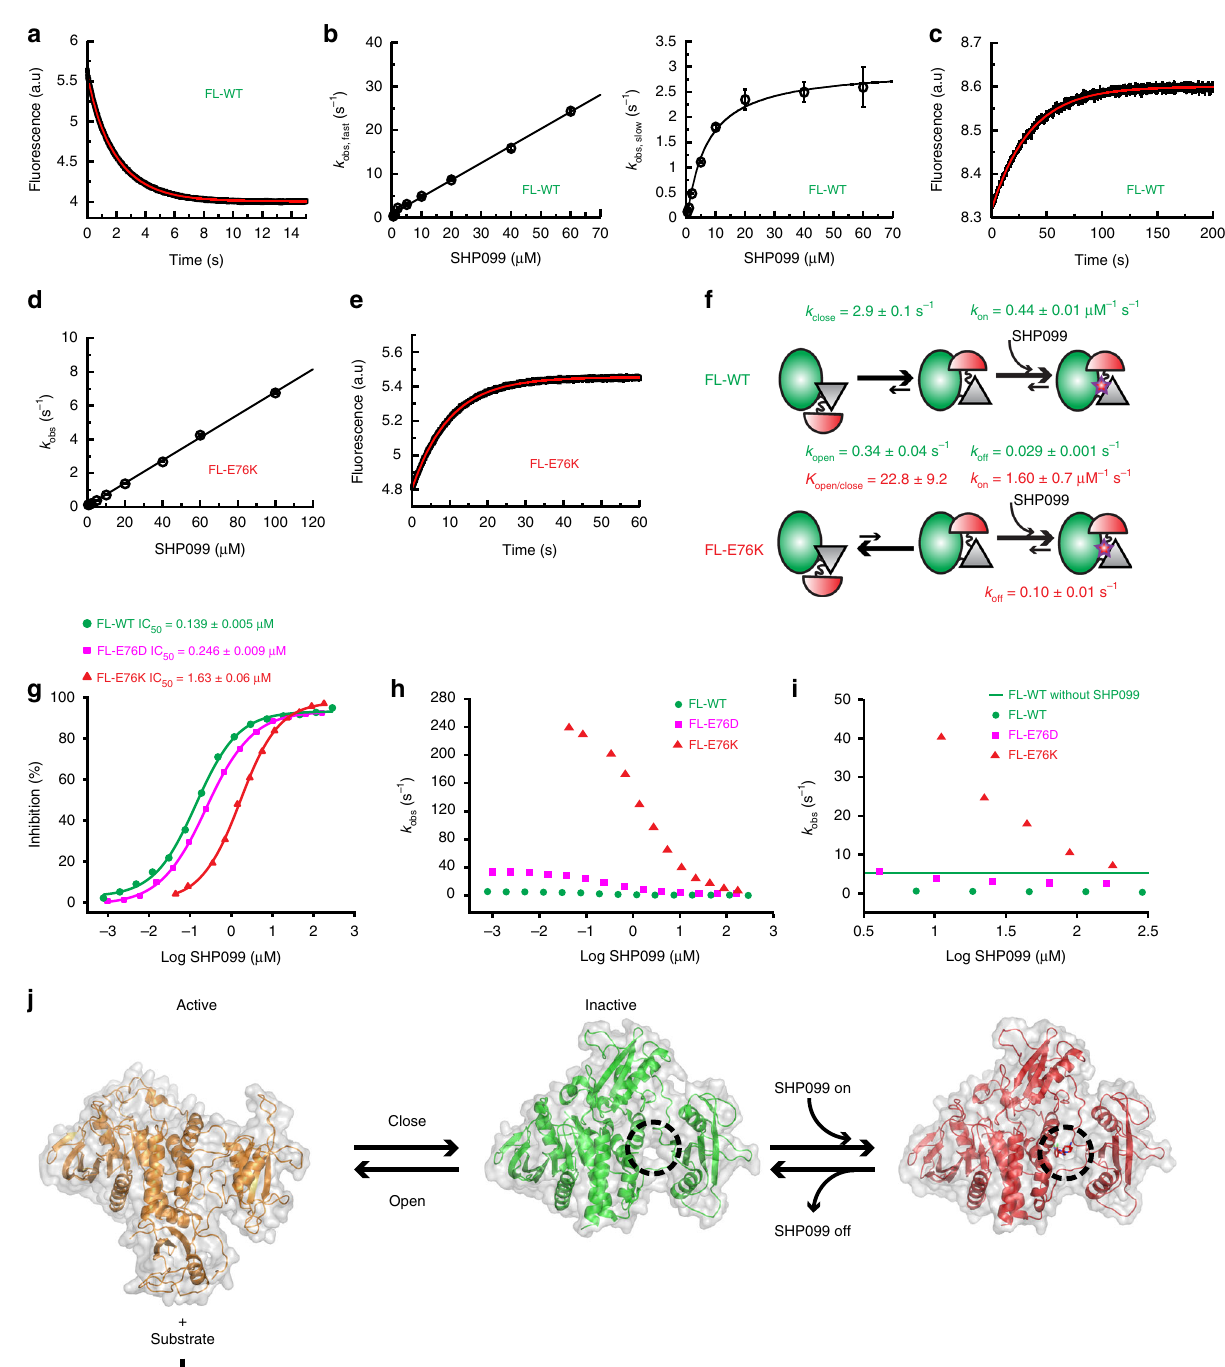
results beg the question: What are the implications of these kinetic differences for drug development? Although SHP099 has been shown to possess excellent potency against FL-WT 1 , it should have a much weaker IC 50 for the oncogenic mutants based on our binding kinetics. Indeed, the FL-E76K mutant experiences a signi fi cantly weakened inhibition pro fi le for SHP099 with a >10-fold higher IC 50 (Fig. 6g). As predicted from a conforma- tional selection model, FL-E76D has an intermediary IC 50 value as it samples a closed population in between WT and